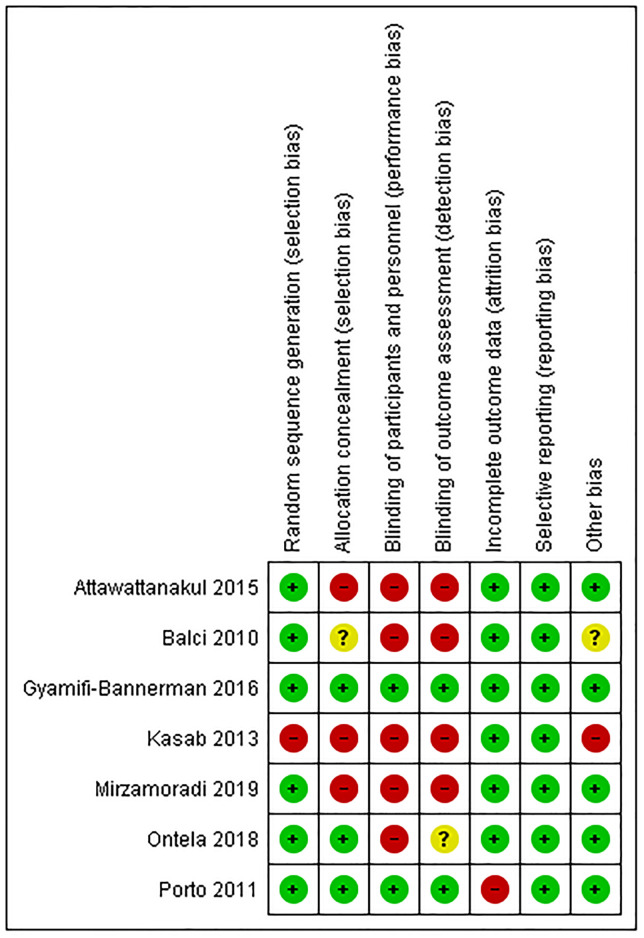
Risk of bias summary.